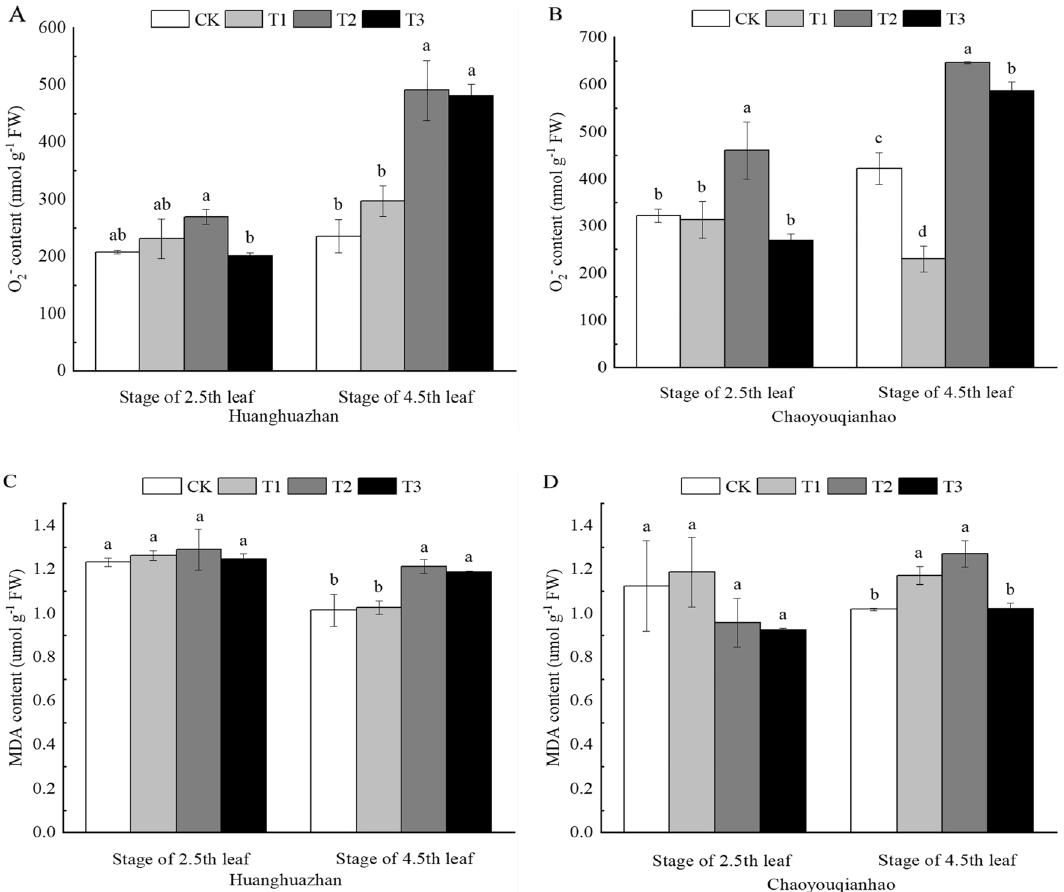
Figure 4. Effects of soaking with BR on the contents of MDA and O 2 · − of rice seedlings under salt stress. Different lowercase letters indicate significant differences at the P < 0.05 level. CK: soaking with distilled water + watering 0 g L −1 NaCl. T1: soaking with BR + watering 0 g L −1 NaCl. T2: soaking with distilled water + watering 3 g L −1 NaCl. T3: soaking with BR + watering 3 g L −1